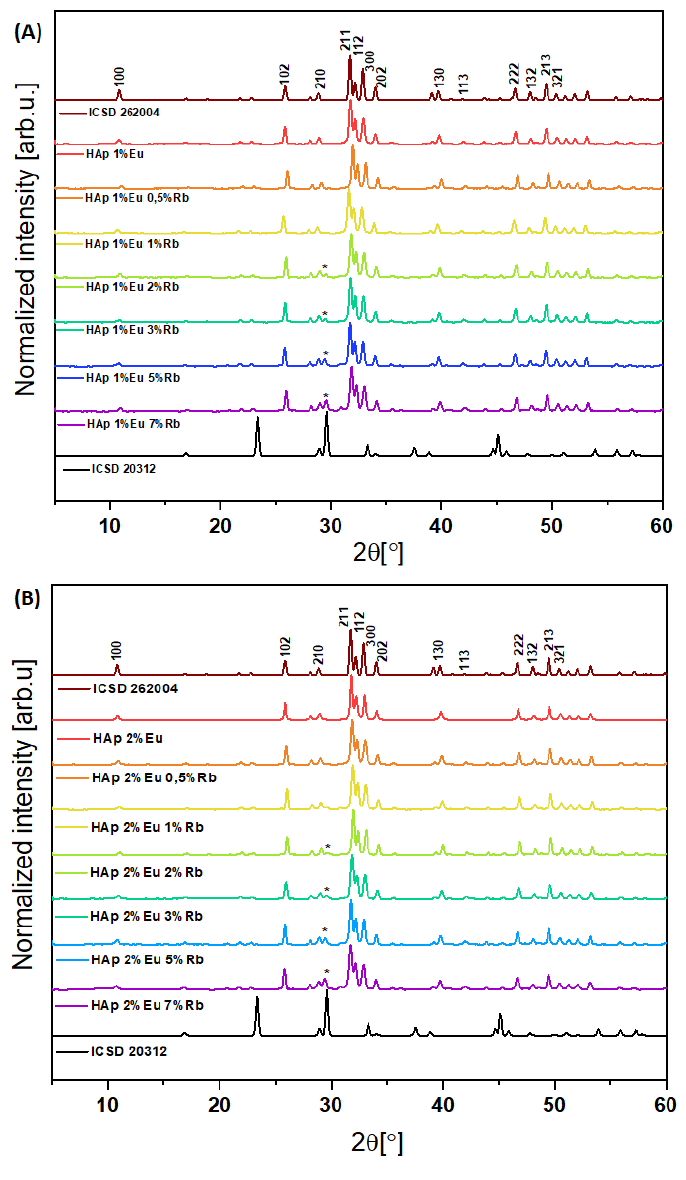
Figure 1. XRD results of Ca 10 − (0.1 + x) Eu 0.1 Rb x (PO 4 ) 6 (OH) 2 ( A ), and Ca 10 − (0.2 + x) Eu 0.2 Rbx(PO 4 ) 6 (OH) 2 ( B ), where x equals 0.5, 1, 2, 3, 5, 7 mol% of Rb+ ions. The obtained materials were thermally treated at a temperature of 500 °C for 3 h. The XRD results are compared with the ICSD database hydroxyapatite. (*) RbH 2 PO 4 (ICDS 20312) [18,19].